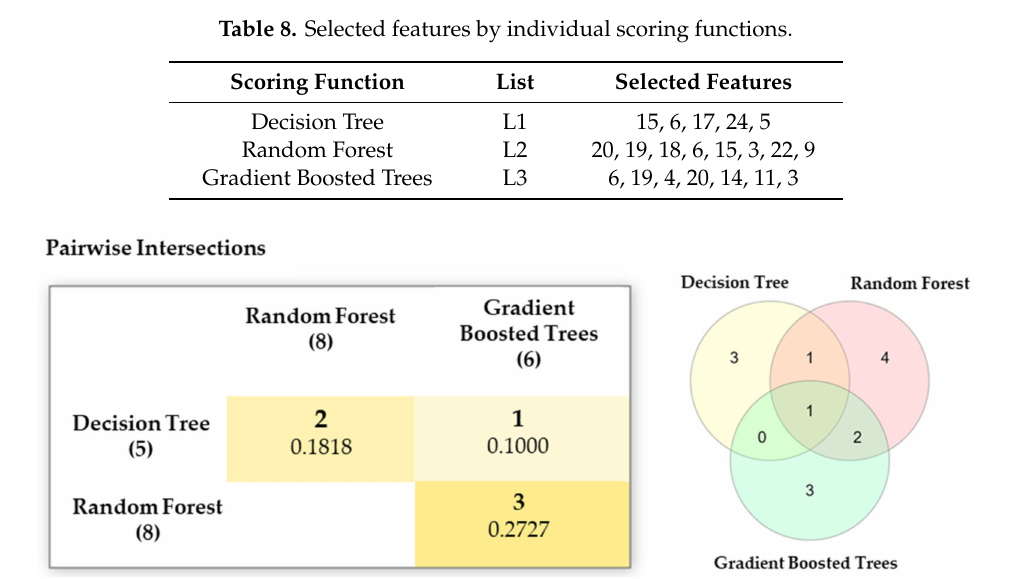
Figure 9. Jaccard index for di ff erent feature